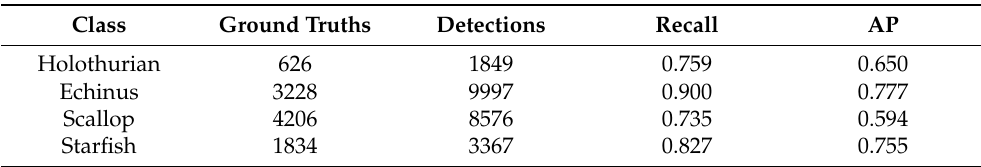
Figure 7. Test results for the holothurian, echinus, scallop, and starfish. Table 1. Recall and average precision of the underwater data set with an IoU threshold of 0.5 for the proposed framework.